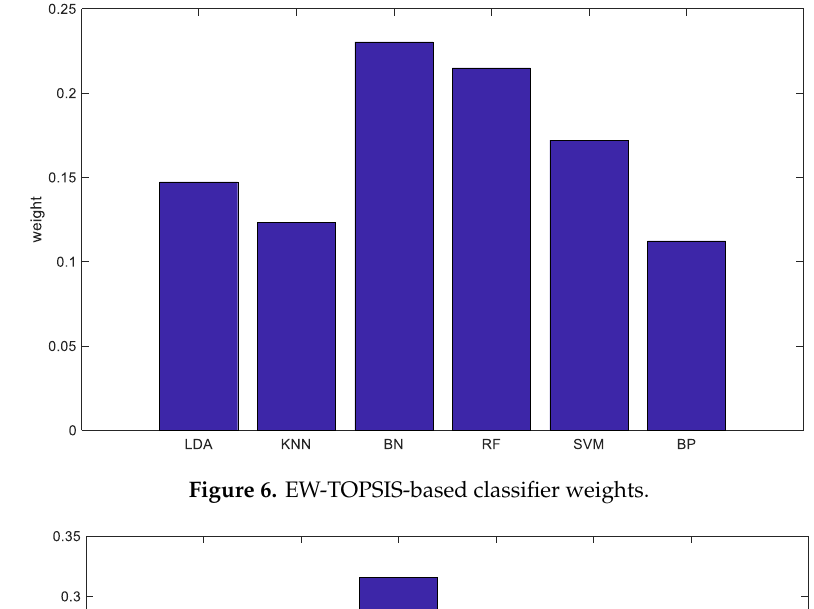
Figure 5. Value of each base classifier relative to each performance evaluation indicator